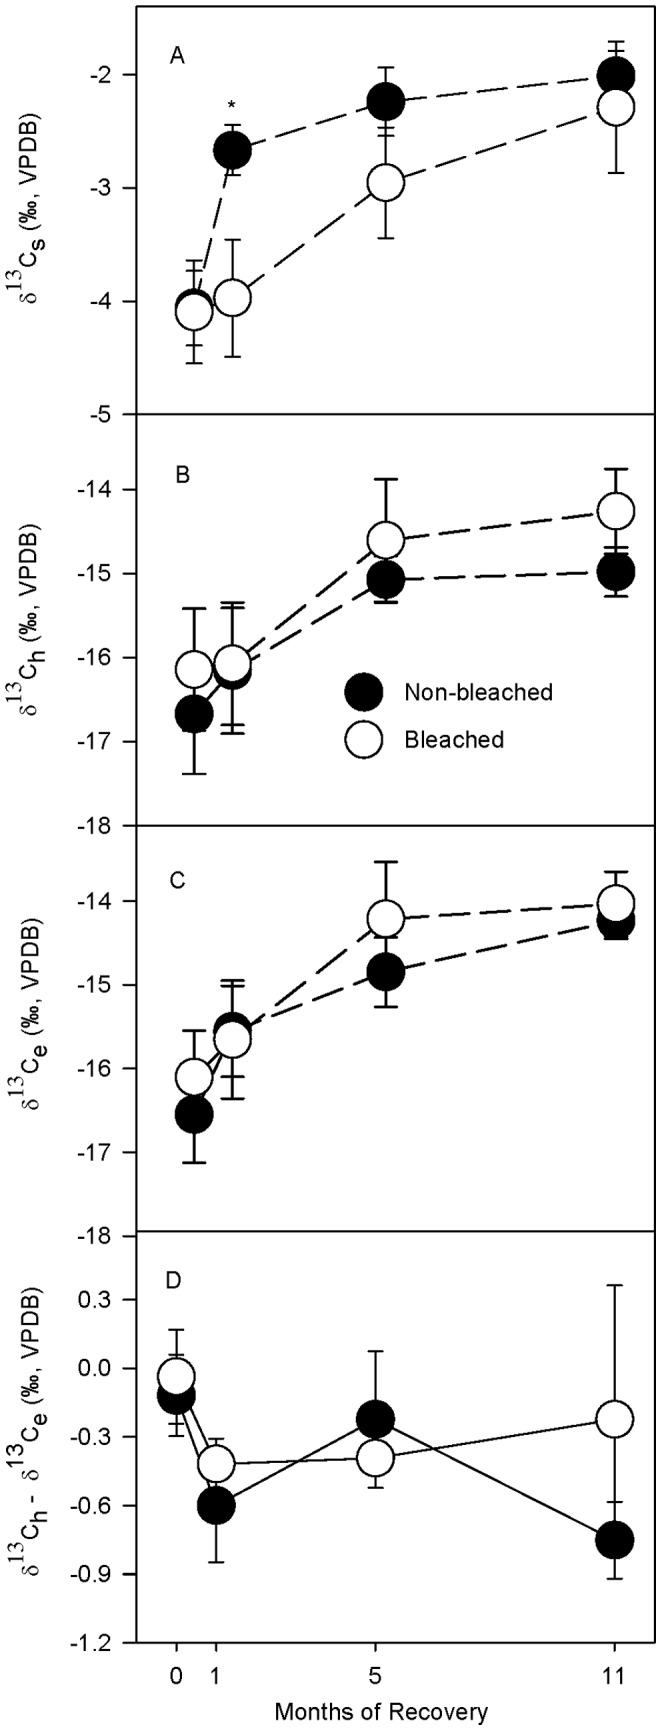
δ13C of the skeleton, animal host, and endosymbiont.Average δ13C of the (A) skeletal (δ13Cs), (B) host tissue (δ13Ch), (C) endosymbiont (δ13Ce) fractions, and (D) the difference between δ13Ch and δ13Ce in Porites lobata at 0, 1, 5, and 11 months of recovery. In D, heterotrophy contributes more to the fixed carbon pool when the difference is <0, while photosynthesis contributes more when the difference is >0. All averages are ±1 SE. Symbols (*) indicate significant difference at p0.05 between non-bleached (•) and bleached (○) within a recovery interval using a posteriori least-squares mean slice tests. Sample sizes for each average ranged from 3 to 6.